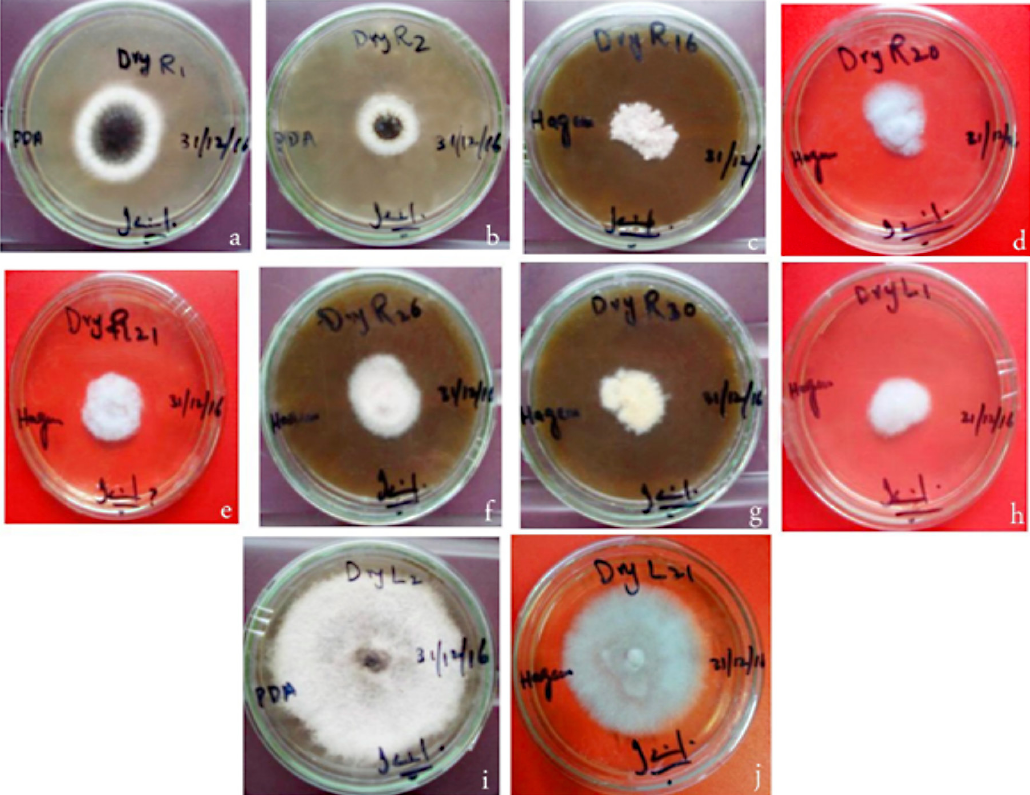
Fig. S1: Colonies of endophytic fungi grown on Hagam minimal medium and purified on PDA media plates, isolated from Dryopteris L. Ten different fungal colonies were isolated from the host plant, 7 from roots and 3 from leaves i.e. DryR-1, DryR-2, DryR-16, DryR-20, DryR-21, DryR-26, DryR-30,